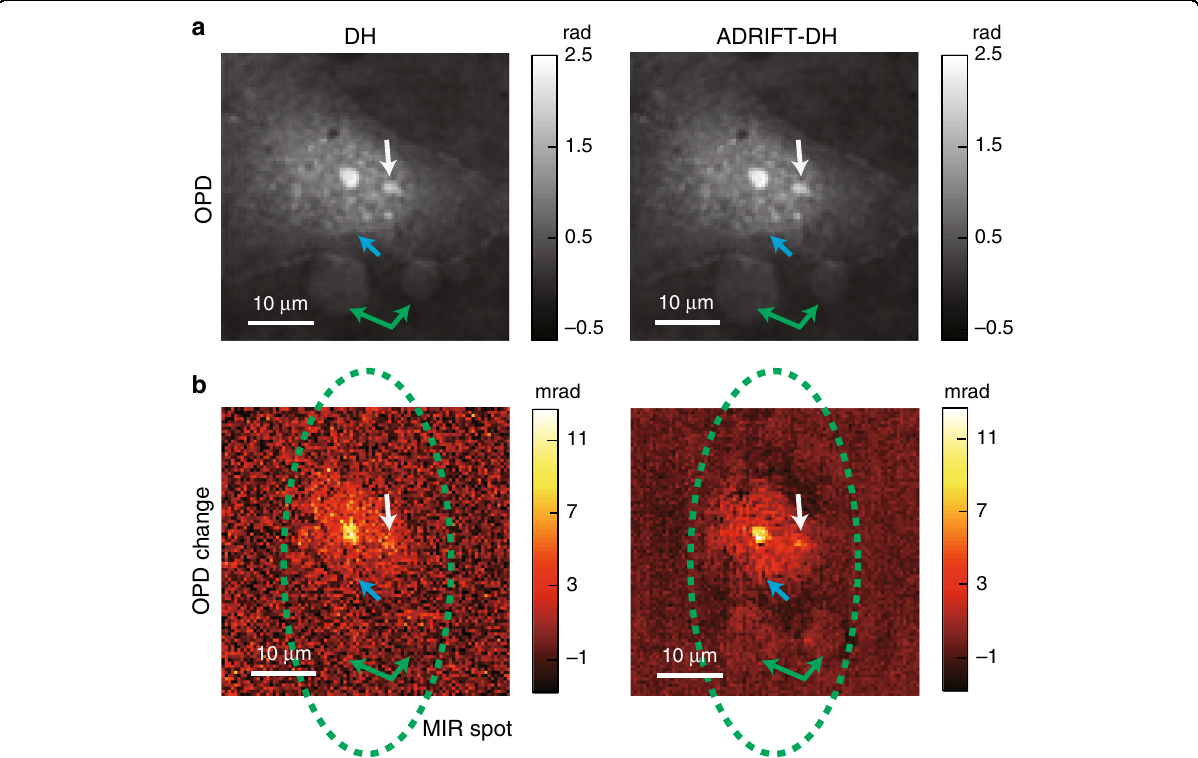
Fig. 5 Dynamic-range-expanded MIR photothermal QPI of a live COS7 cell. a OPD images measured by DH (left) and ADRIFT-DH (right) in the MIR OFF state. The white, blue and green arrows show the existence of the nucleoli, nucleus and two particles, respectively. b Images of the photothermal OPD changes due to absorption of the MIR pump light measured by DH (left) and ADRIFT-DH (right). The area in the green dotted circle indicates the illumination spot of the MIR pump light. The structures indicated by the white (nucleoli), blue (nucleus) and green (particles) arrows in ( a ) also give stronger signals in the photothermal images shown in ( b ), which is visualized clearly with ADRIFT-DH but not with